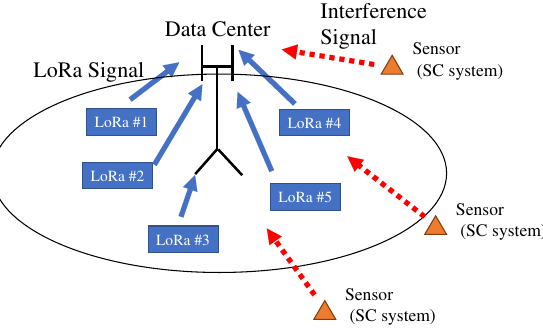
Figure 1. System overview of assumed wireless sensor networks. Frequency spectrum sharing between LoRa and single-carrier systems was considered.